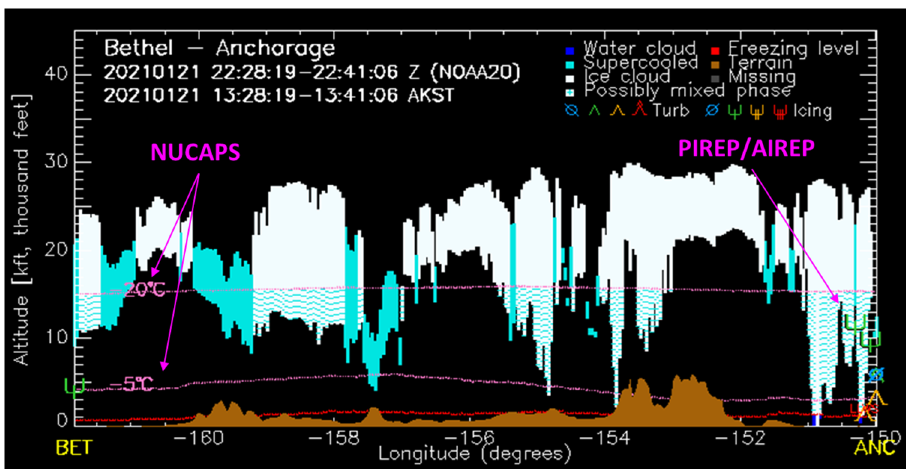
Figure 11. Sample cloud vertical cross-section between Bethel and Anchorage, Alaska from NOAA-20 VIIRS at 2228 UTC on 21 January 2021.